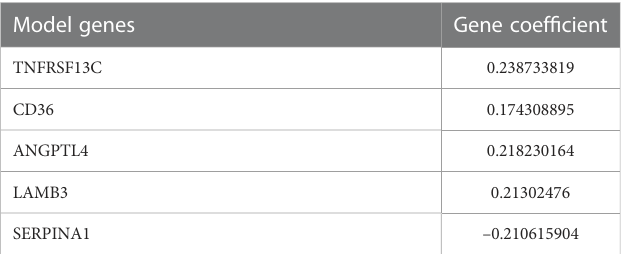
TABLE 1 Gene coef fi cients of model genes.